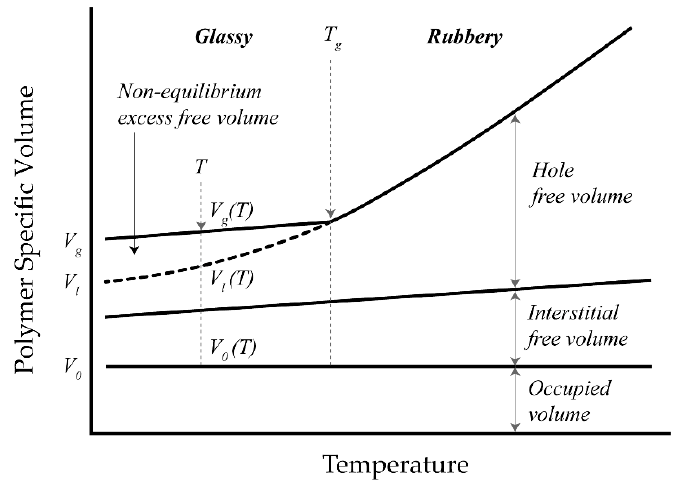
Figure 4. Schematic representation of polymer volume as a function of temperature. Reproduced with permission from [122]; V g and V l are the polymer specific volume (cm 3 ) in the glassy and hypothetical rubbery state, respectively, and V 0 is the occupied volume at 0 K.